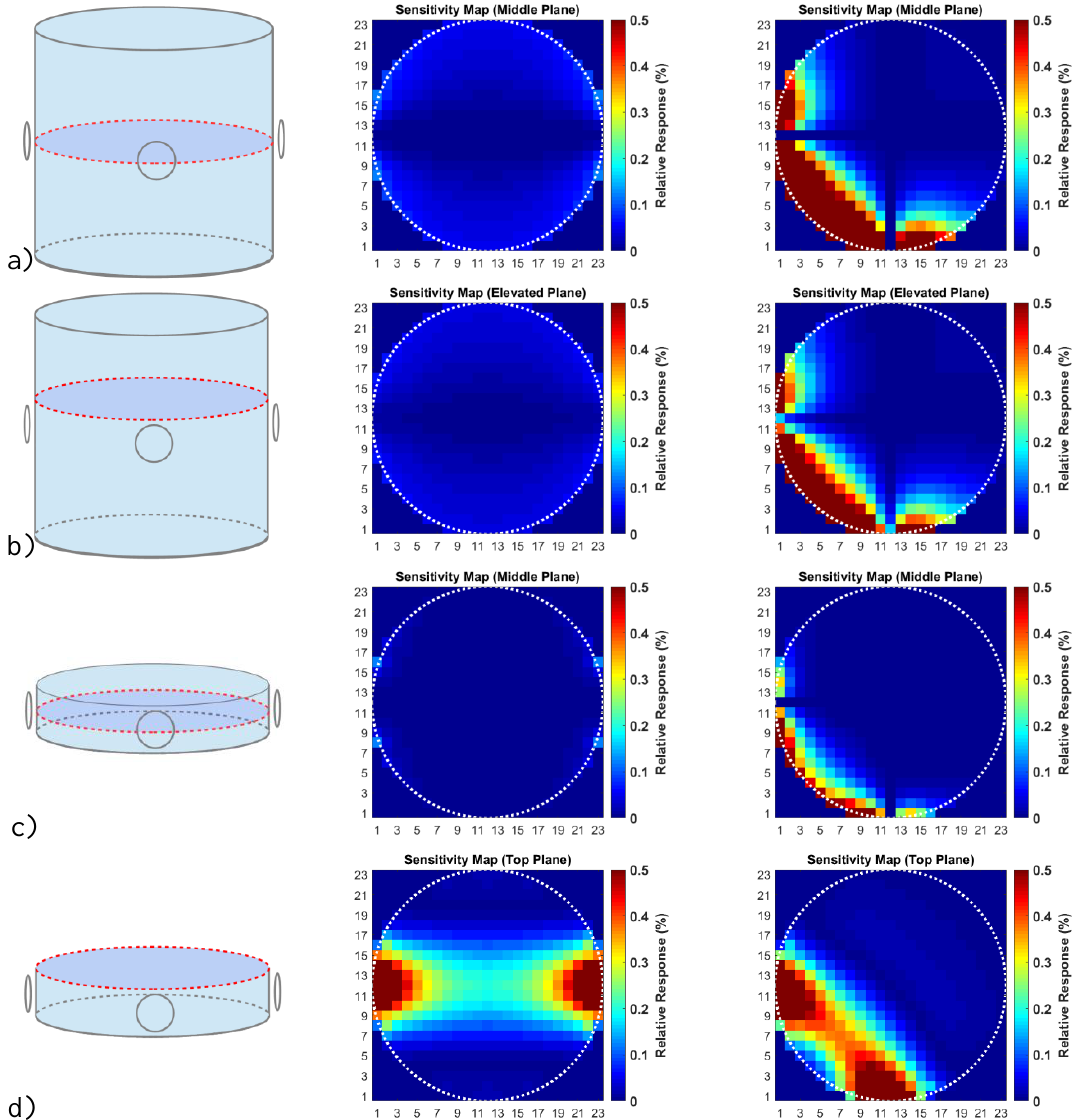
Figure 1. Circular MIT system with exciter and receiver coils in two typical alignments, i.e., in opposing and rectangular placements (left column). Middle and right column: Calculated sensitivity maps, the signal deviations (sensitivity), due to a local conductivity change are shown in relation to the total signal from the conductive volume. Middle column: Opposing coil placements. Right column: Rectangular coil placements. ( a ) Horizontal middle plane of an elongated saline cylinder; ( b ) vertically elevated plane; ( c ) the horizontal middle plane of a shallow bath is virtually undetectable; ( d ) the top plane of a shallow saline cylinder demonstrates very satisfactory detectivity throughout the